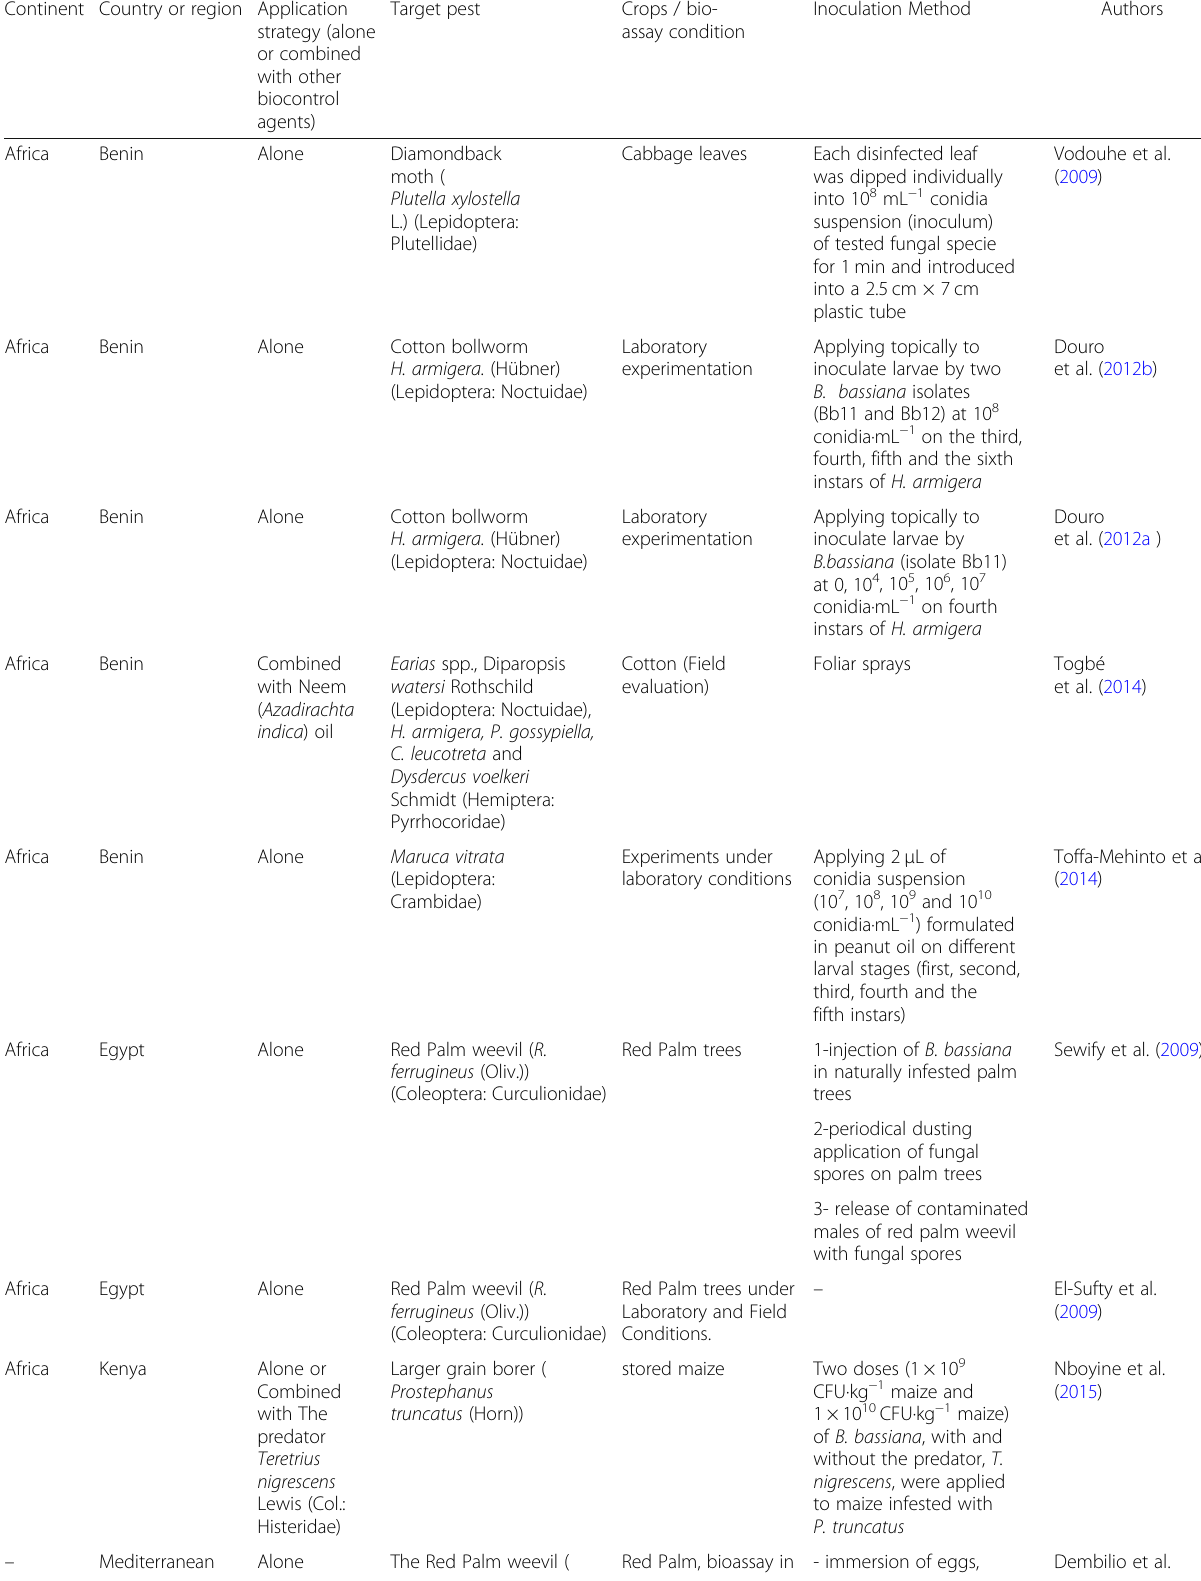
Table 1 Summary of the control programs that successfully used Beauveria bassiana for crop protection from 2009 to 2019 Continent Country or region Application strategy